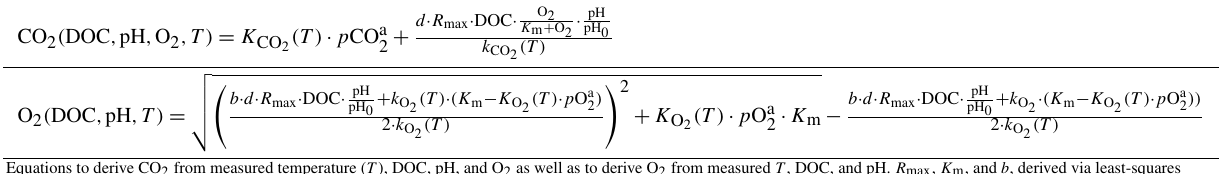
Table 1. Equations to derive CO 2 and O 2 based on the linear pH approach.